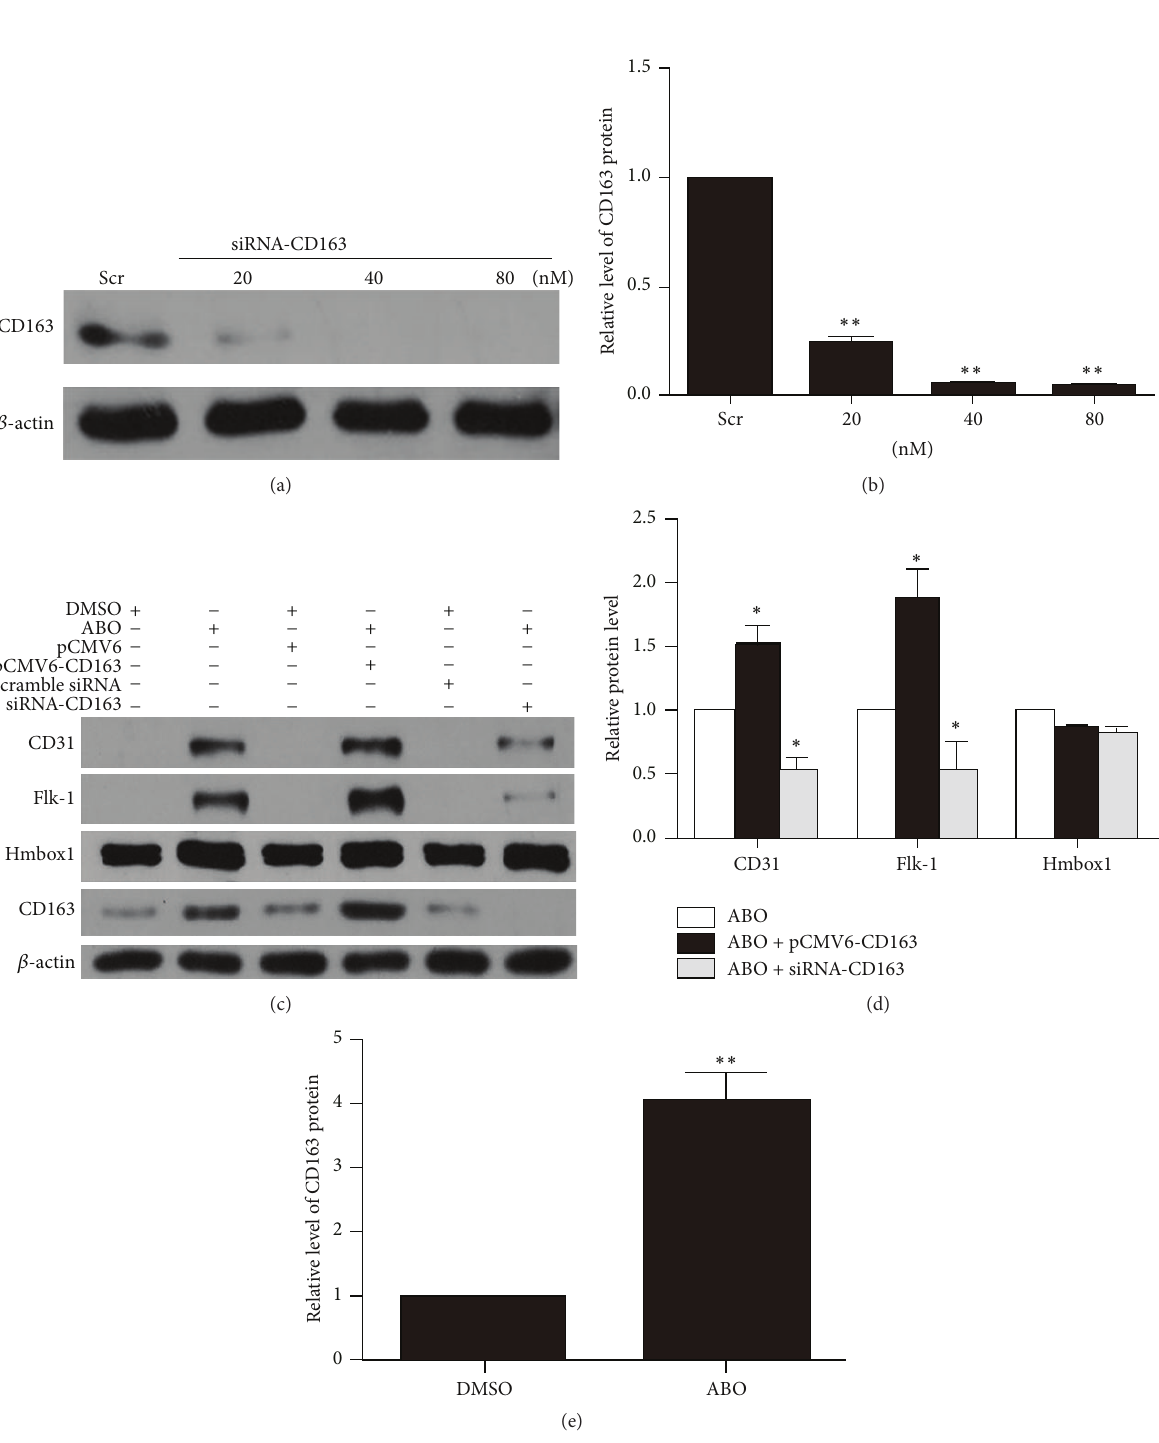
Figure 3: The protein level of CD163 influenced ABO-induced BMSC differentiation. For CD163 interference, cells were subjected with 80 nmol/L scrambled siRNA or 20, 40, and 80 nmol/L CD163 siRNA for 6 h and cultured for 48 h. Scr: scrambled RNA as negative control. (a) Western blot analysis of CD163 RNA interference efficiency. (b) Relative levels of CD163 protein were calculated based on densitometry analysis. (c) Western blot analysis of the protein level of CD31, Flk-1, Hmbox1, and CD163 after overexpression or knockdown of CD163 with or without 50 𝜇 M ABO treatment (DMSO as control). ((d)-(e)) Relative protein levels of CD31, Flk-1, Hmbox1, and CD163 were calculated based on densitometry analysis. Data are mean ± SEM. ∗ 𝑝 < 0.05 versus ABO group, ∗∗ 𝑝 < 0.01 versus control (Ctr), 𝑛 ≥ 3